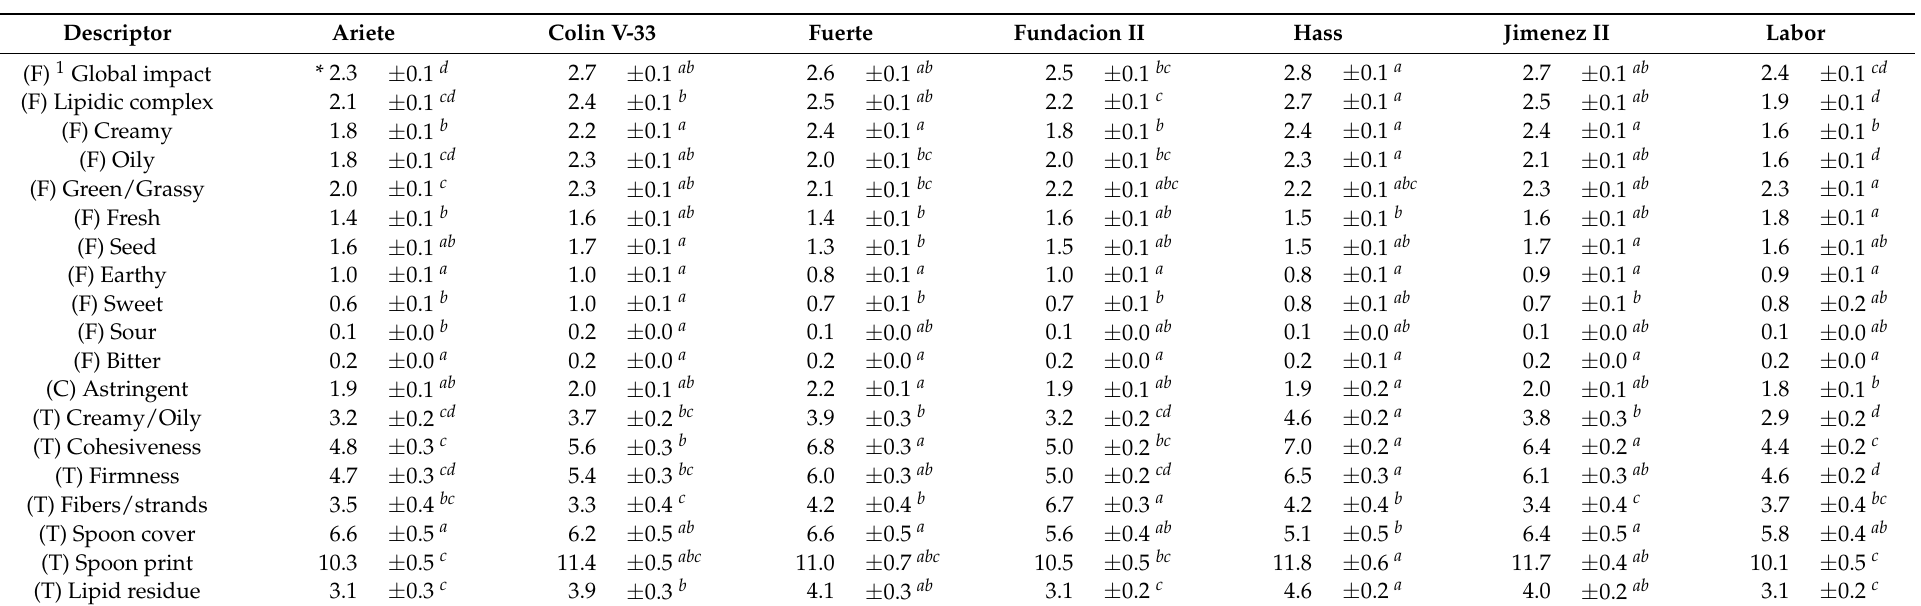
Table 4. Intensity ratings of nineteen descriptive attributes for seven commercial and non-commercial avocado